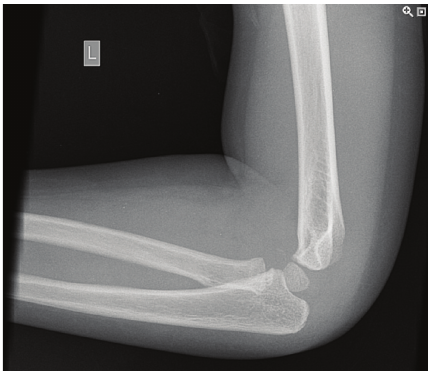
Figure 1: Lateral radiograph of three-year-old boy showing olecra- non fracture.